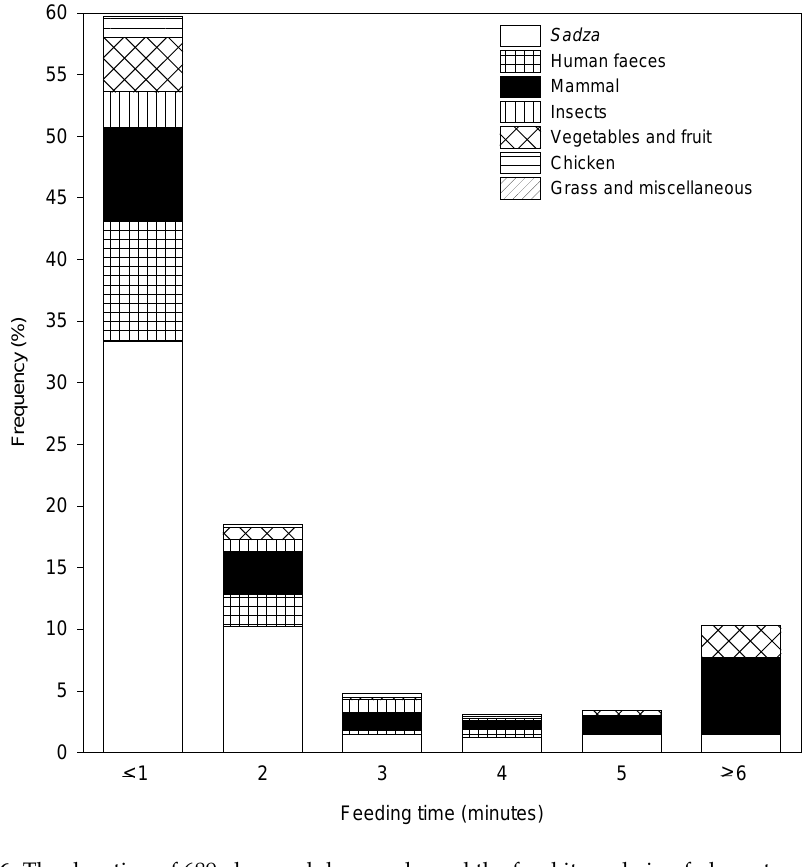
Figure 6. The duration of 689 observed dog meals, and the food items being fed on at each meal. Animals 2018 , 8 , x